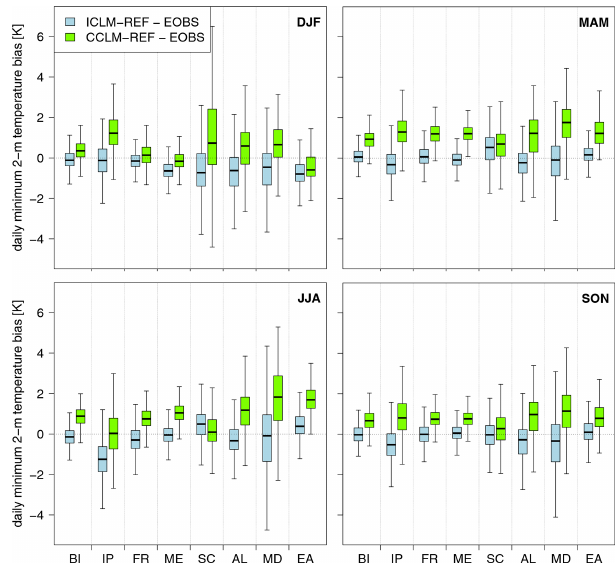
Figure 7. Same as Fig. 5 but for daily minimum 2m